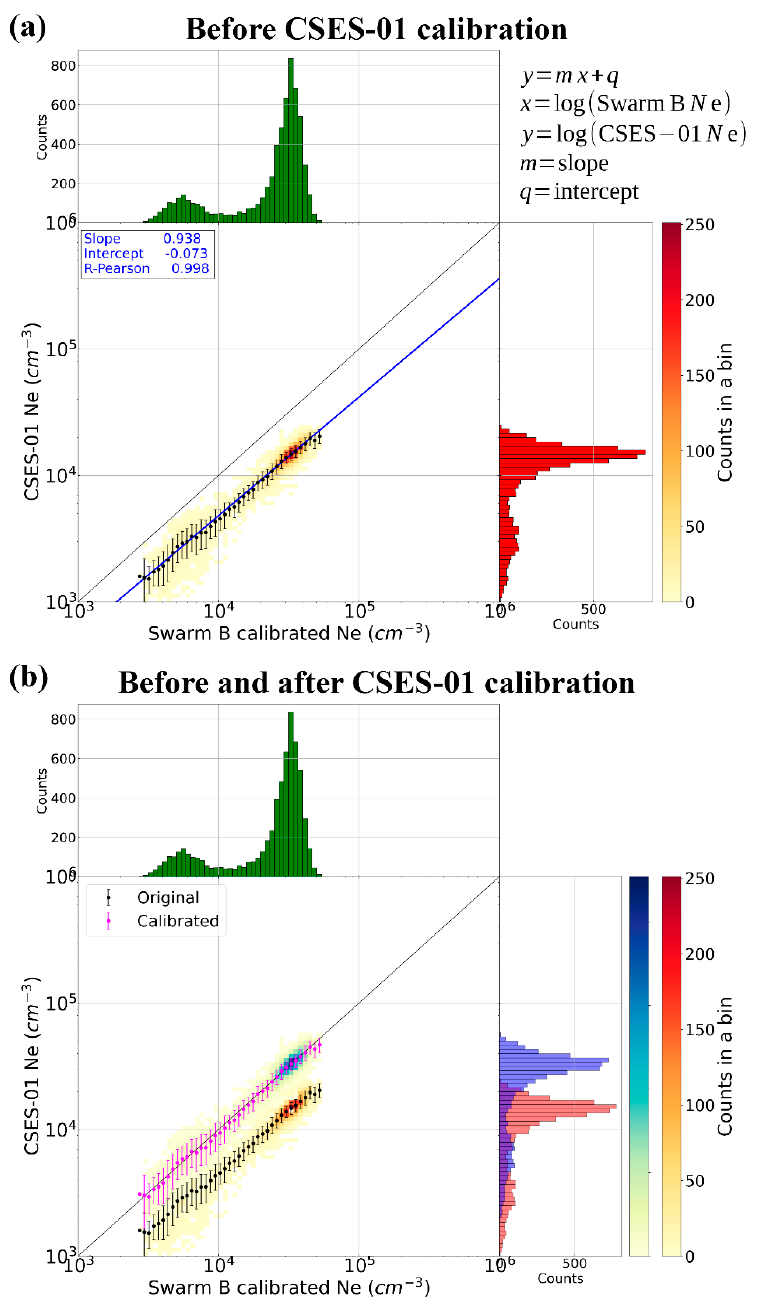
Figure 6. JPDs between CSES-01 LP N e ( y -axis) and Swarm B LP N e calibrated with FP ( x -axis) mean values represented in Figure 4 for the nighttime sector (01:00 − 03:00 LT). Panel ( a ) refers to CSES-01 before the calibration, while Panel ( b ) also shows the distribution of CSES-01 after the calibration. In each panel, histograms of the counts are also reported: on the right and in red for CSES-01 LP before the calibration, in blue for CSES-01 LP after the calibration, and on the top and in green for Swarm B LP N e calibrated with FP. The black dots refer to the mean values of original CSES-01 N e conditioned by Swarm B LP N e calibrated with FP, with the corresponding standard deviation as error bar. The magenta dots refer to the mean values of calibrated CSES-01 N e conditioned by Swarm B LP N e calibrated with FP, with the corresponding standard deviation as error bar. The blue line in Panel ( a ) is the linear fit performed on black dots, with corresponding coefficients given in the legend. The thin black line is the first-third quadrant bisector.